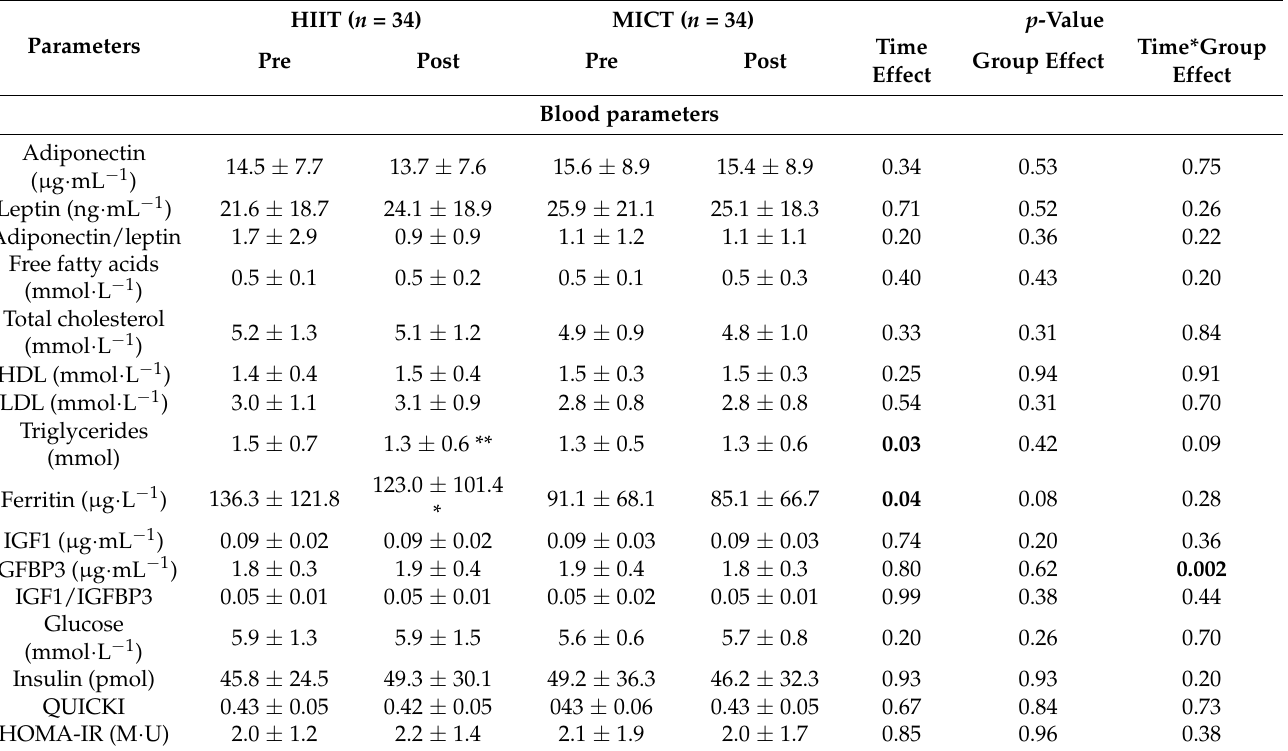
Table 4. Blood parameters in obese older adults following 12 weeks of High-Intensity Interval Training (HIIT) and Moderate-Intensity Continuous Training